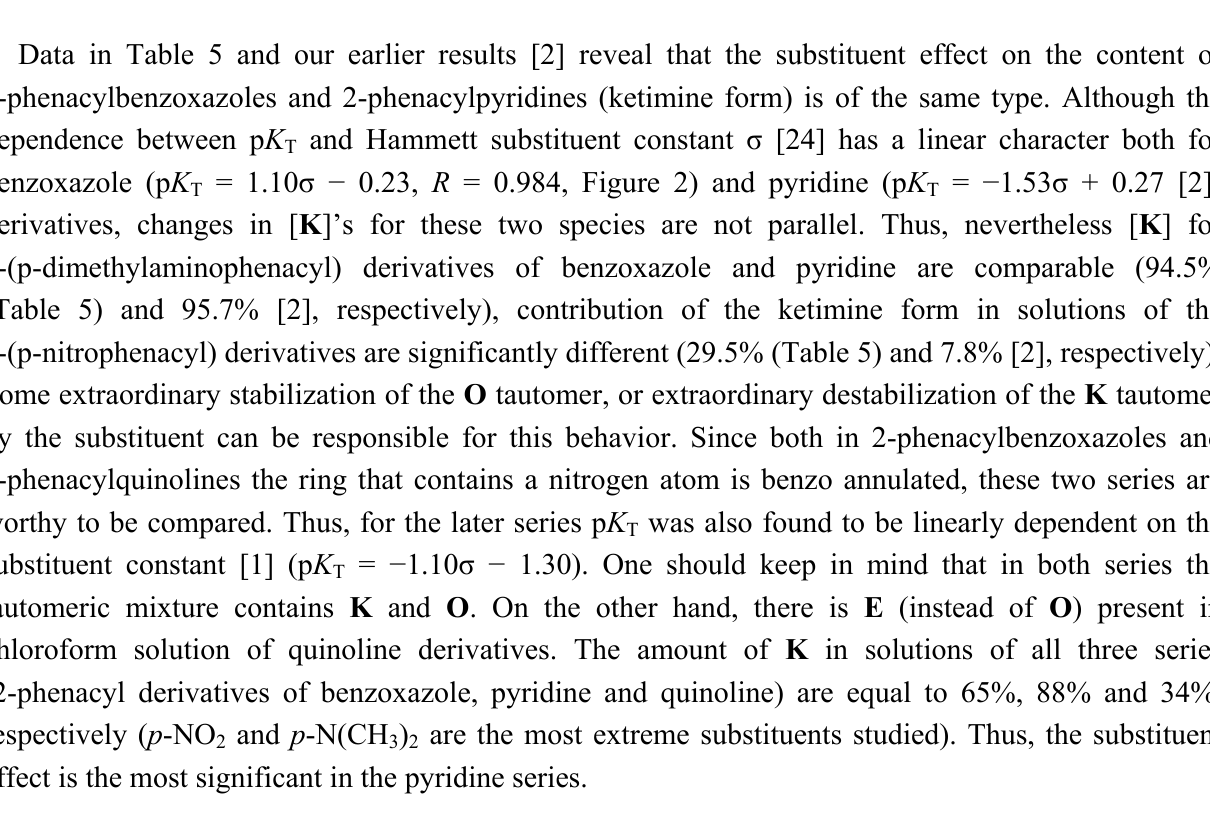
vs. Hammett substituent constant σ for 1b – 11b Figure 2. Plot of − log K T